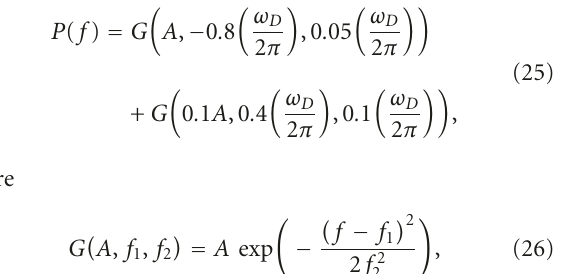
Figure 5: Squared-envelope of the autocorrelations of the first and second taps for common parameters θ (0) 0 = π/ 5, K 0 = 10, and the set of { v }